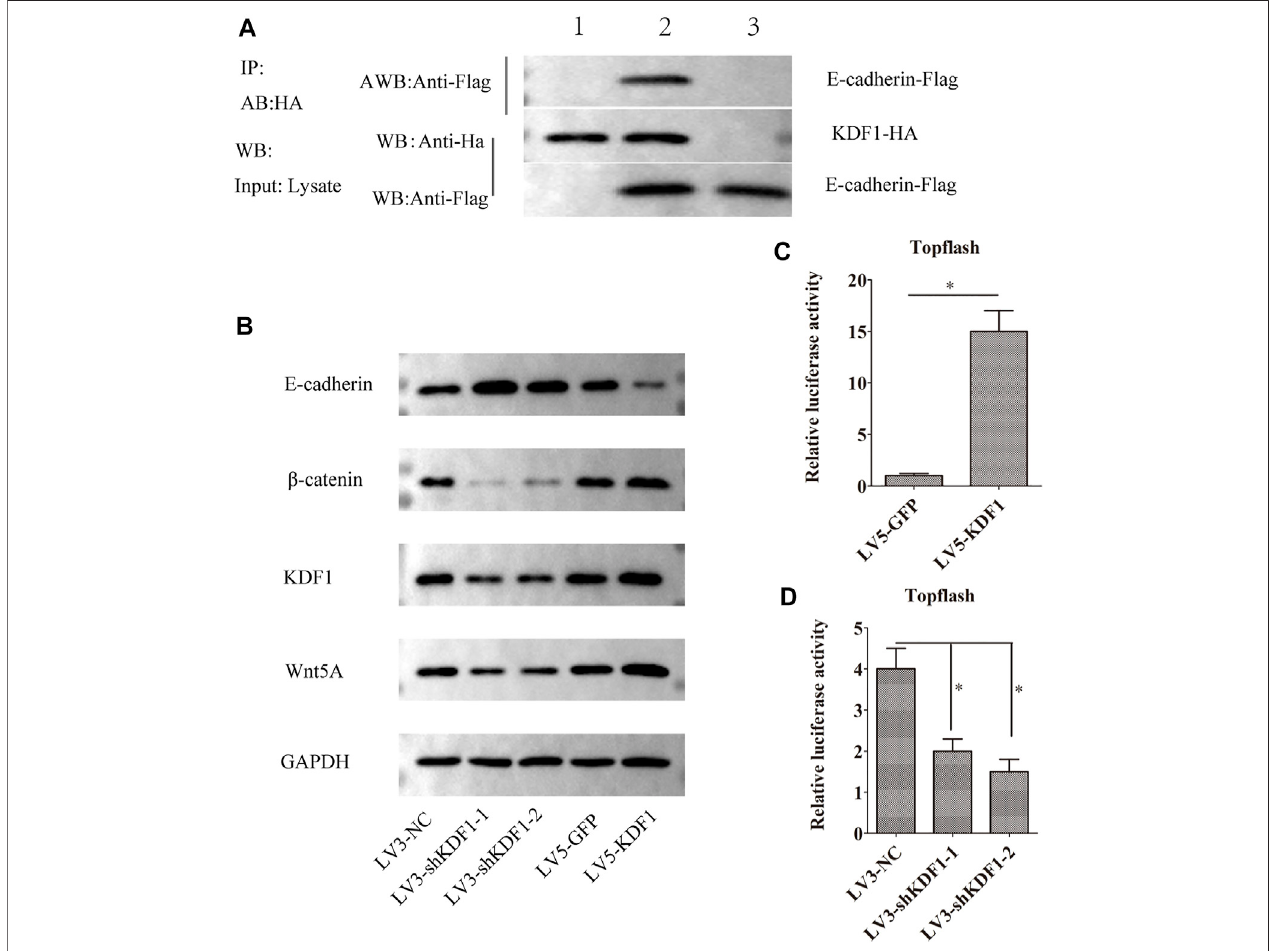
FIGURE 6 | KDF1 participated in the Wnt/ β -catenin pathway in ovarian cancer. The Co-IP experiment detected the interaction between KDF1 and E-cadherin protein (A) .E-cadherin,Wnt5a, β -catenin,andKDF1expressionwasdetectedusingWesternblot (B) .TheregulationofKDF1ontheWntpathwaywastestedusingdual luciferase reporter gene experiments (C,D) . Error bars represent the standard error. *indicates p < 0.05.